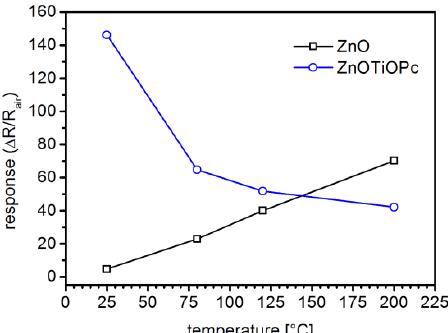
Figure 7. Compared responses of ZnO-TPs and ZnO-TPs+TiOPc based sensors towards 0.5 ppm of NO as a function of temperature (RH 30%). 2